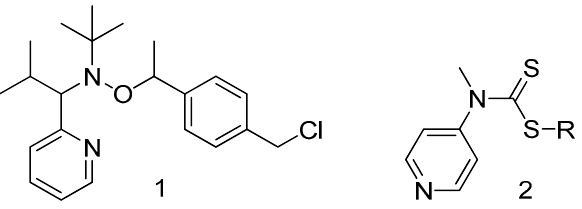
Figure 3. Structure of alkoxyamine 1 and RAFT agent 2 first used for pH-switchable controlled radical polymerization.